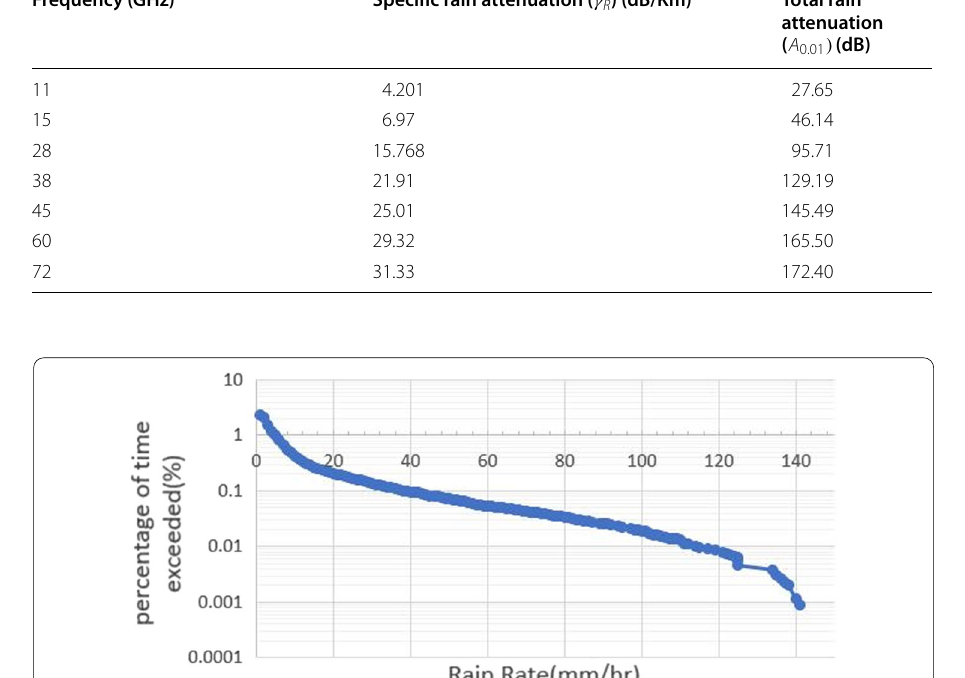
Table 5 Specific and total rain attenuation values at R 0.01 and path distance 13.4 km Frequency (GHz)